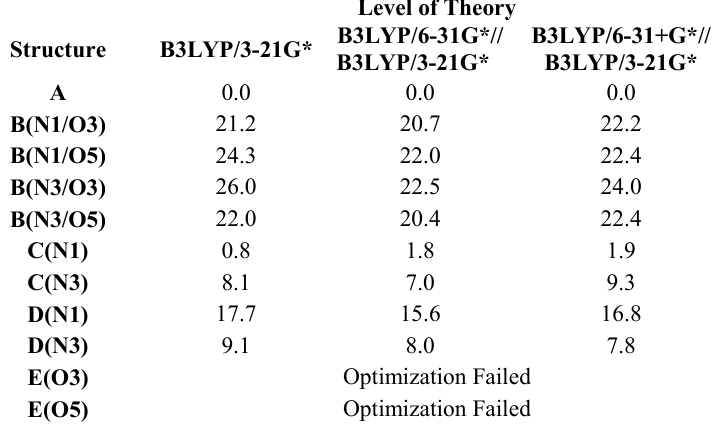
Table 1. Theoretical calculated ∆ G (kcal/mol) for anionic tautomers of pterins at the B3LYP 3-21G ∗ 31G // B3LYP 3-21G